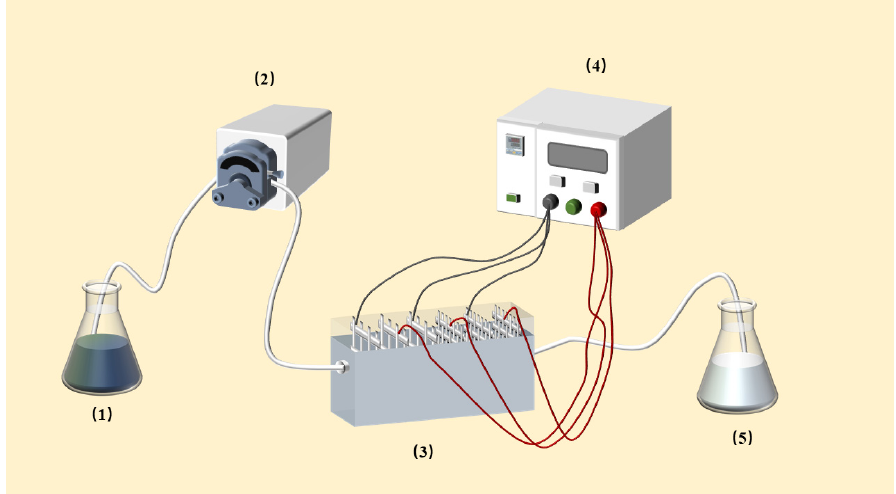
Figure 1. Schematic diagram of the DEP apparatus: (1) storage tank; (2) peristaltic pump; (3) DEP vessel; (4) direct current power source; (5) collection pool.